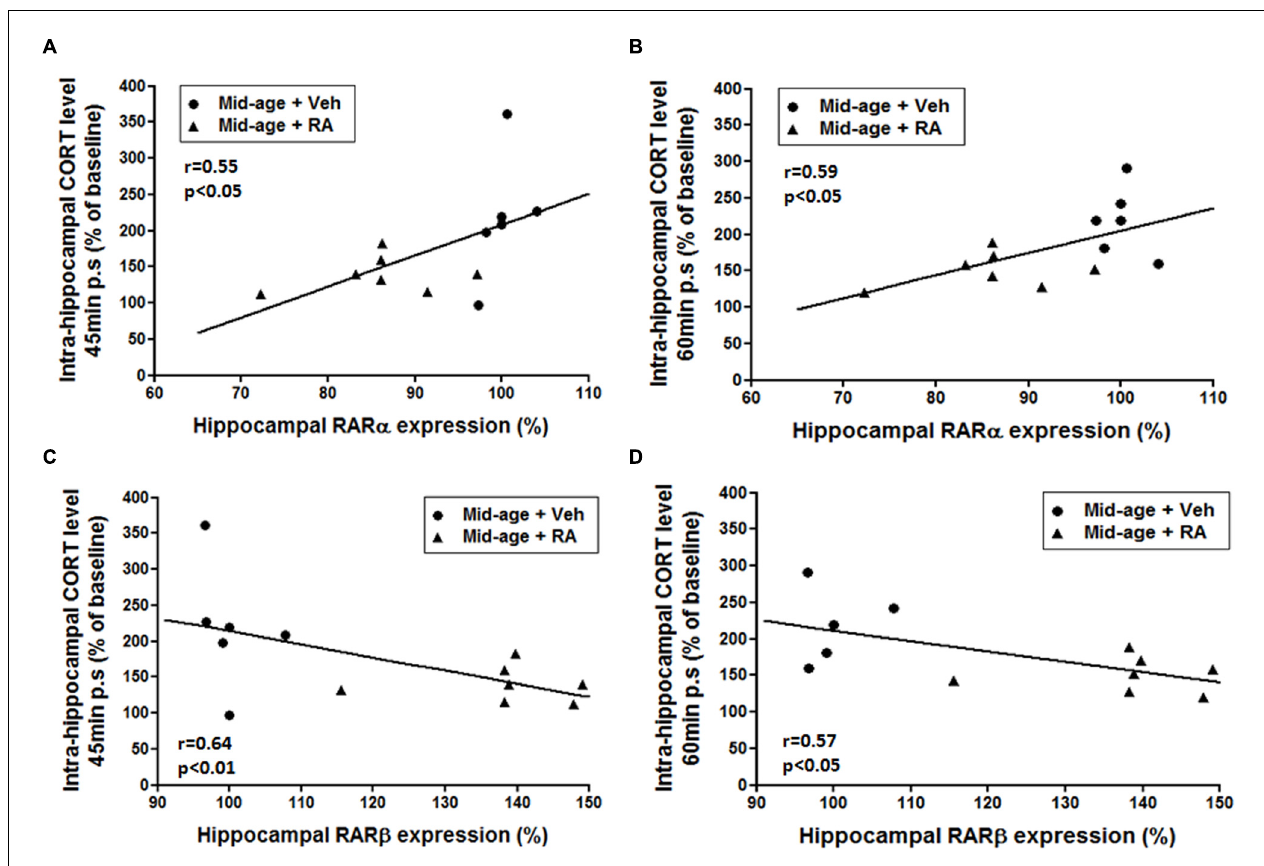
r = 0.59, p < 0.05, respectively). (C,D) Correlation analyzes between RAR β and CORT levels. Intrahippocampal CORT levels [45 min (C) and 60 min (D) post-stress] negatively correlated with RAR β hippocampal mRNA expression ( r = 0.64, p < 0.01 and r = 0.57, p < 0.05,